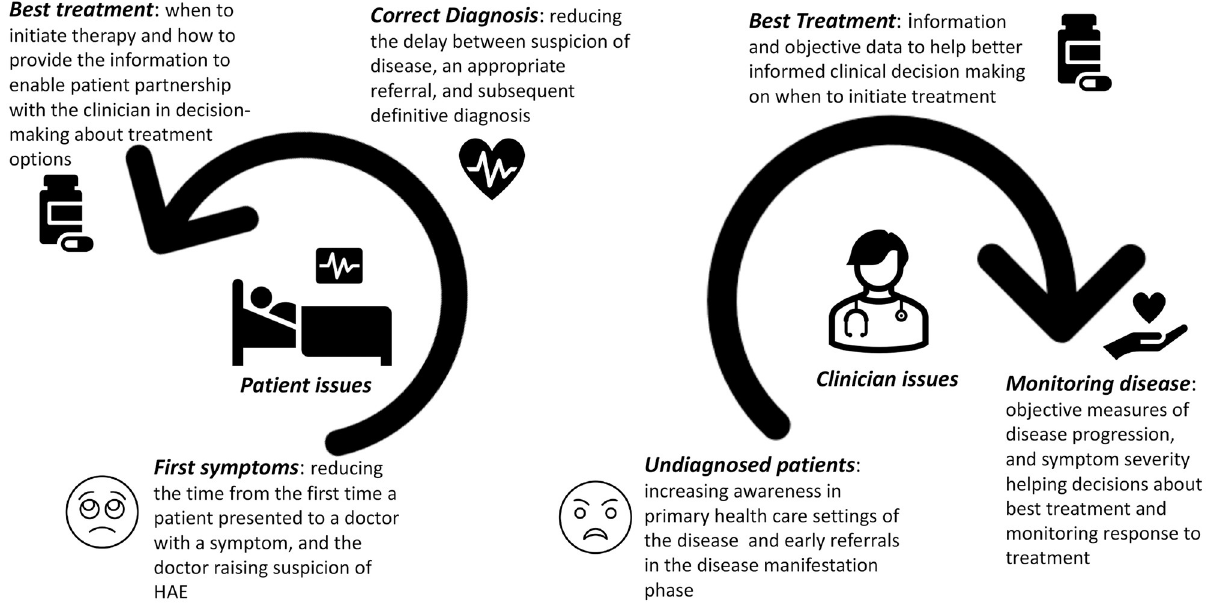
Fig 1. Key issues reflected different perspectives and consequential subjective differences in weightage to priorities applied by clinicians and patients. A universal roadmap emerged through the consultation process, specifically that the QoL issues were integral to optimizing outcomes and reducing the overall impact of the burden of disease for both the stakeholders—the patient and the health